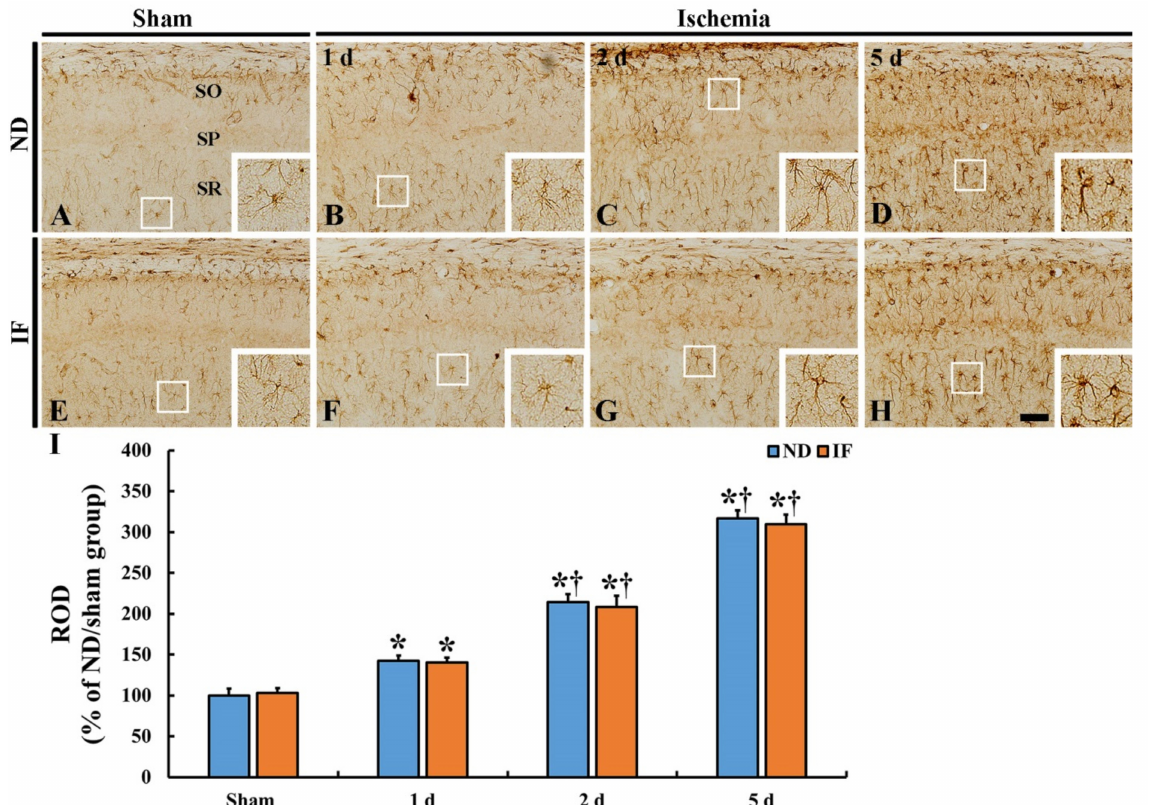
Figure 7. Glial fibrillary acidic protein (GFAP) immunohistochemistry in the CA1 region of the ND (upper column) and IF (lower column) groups at sham ( A , E ), 1 day ( B , F ), 2 days ( C , G ) and 5 days ( D , H ) after ischemia. In both of the groups, the GFAP immunoreactivity is significantly increased with time following ischemia, showing no difference in the immunoreactivity between the two groups. Scale bar = 50 µ m. ( I ) Relative optical density (ROD) of GFAP immunoreactivity as percent values in the CA1 region ( n = 7 in each group, * p < 0.05 vs. ND/sham group, † p < 0.05 vs. pre-time point group of each group by post hoc Tukey’s test). Bars indicate the means ± SEM. IF, intermittent fasting; ND, normal diet; SO, stratum oriens; SP, stratum pyramidale; SR, stratum